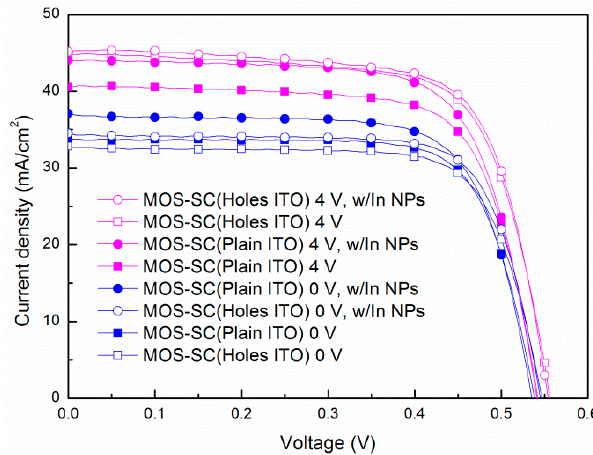
Figure 6. Photovoltaic J-V curves of MOS cells with and without In-NPs as a function of voltage applied to the ITO electrode (0 and 4 V).